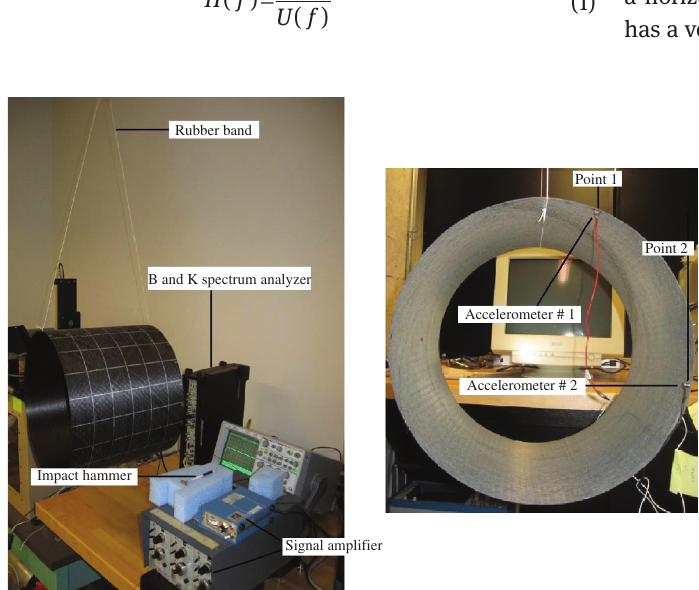
Figure 4: (A) experimental setup; (B) accelerometers